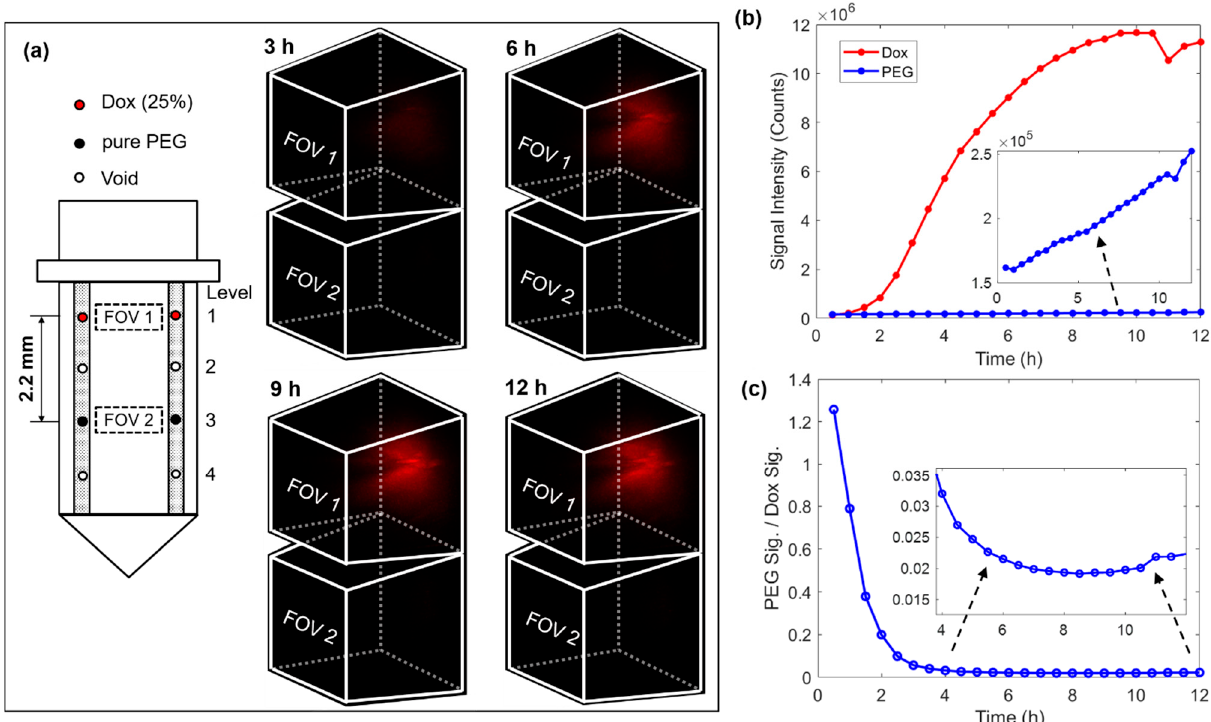
Figure 4. 4D imaging of local doxorubicin delivery in murine tumors using the developed MI-MD system. ( a ) Drug loading diagram and the delivery processes captured by the MI-MD system. Dimensions of the FOV and orientation of the imaging probe relative to the FOV are identical to those in Figure 3b. ( b ) Variation of the overall fluorescence signal for both the doxorubicin compound and pure PEG and ( c ) their ratio as a function of time.